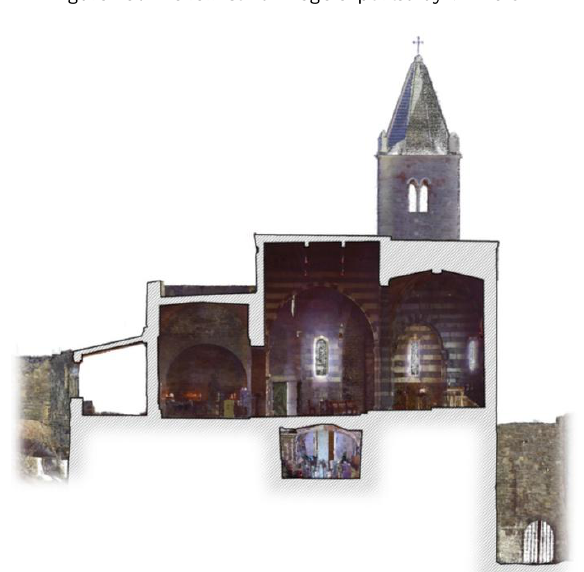
Figure 14 . The solid image after the graphic